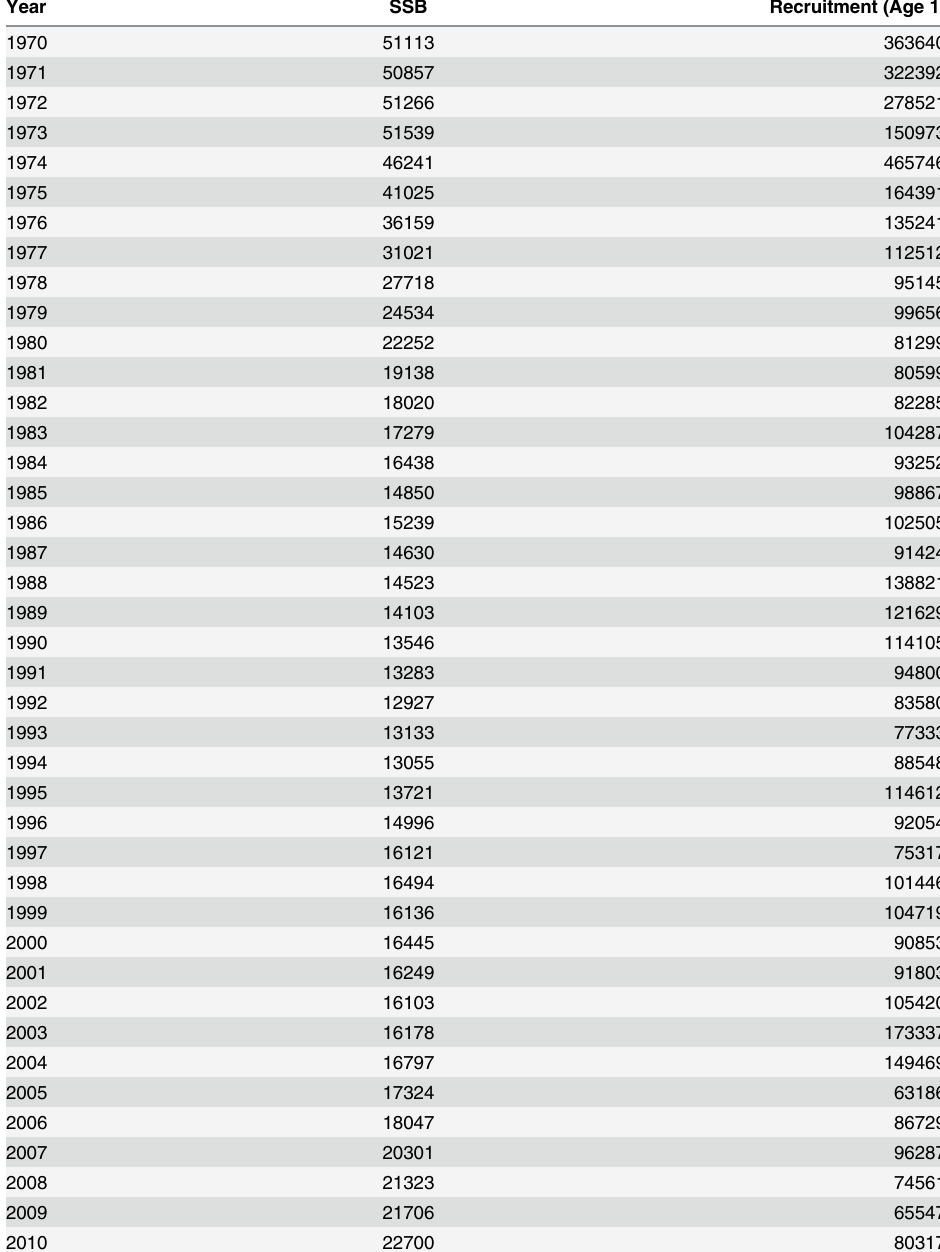
Table 1. Spawning stock biomass (t) and recruitment estimates (in number) from the 2014 stock assessment (note that results for the last three years were not included in the AICc computations because they were considered to be poorly determined by the assessment working group).